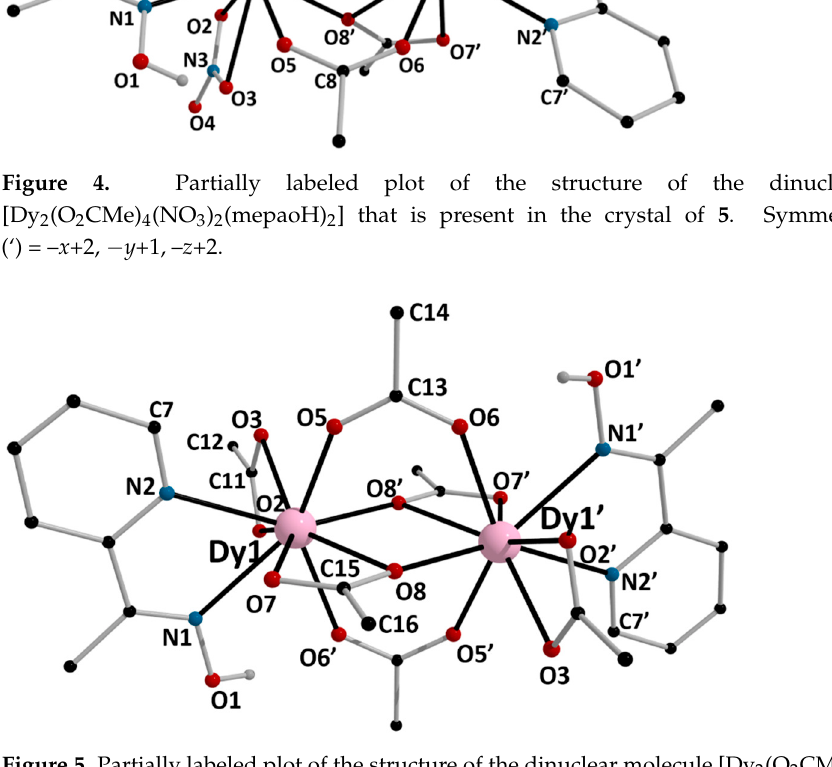
Figure 5. Partially labeled plot of the structure of the dinuclear molecule [Dy 2 (O 2 CMe) 6 (mepaoH) 2 ] that is present in the crystal of 6 . Symmetry operation: (‘) = − x , − y , − z .